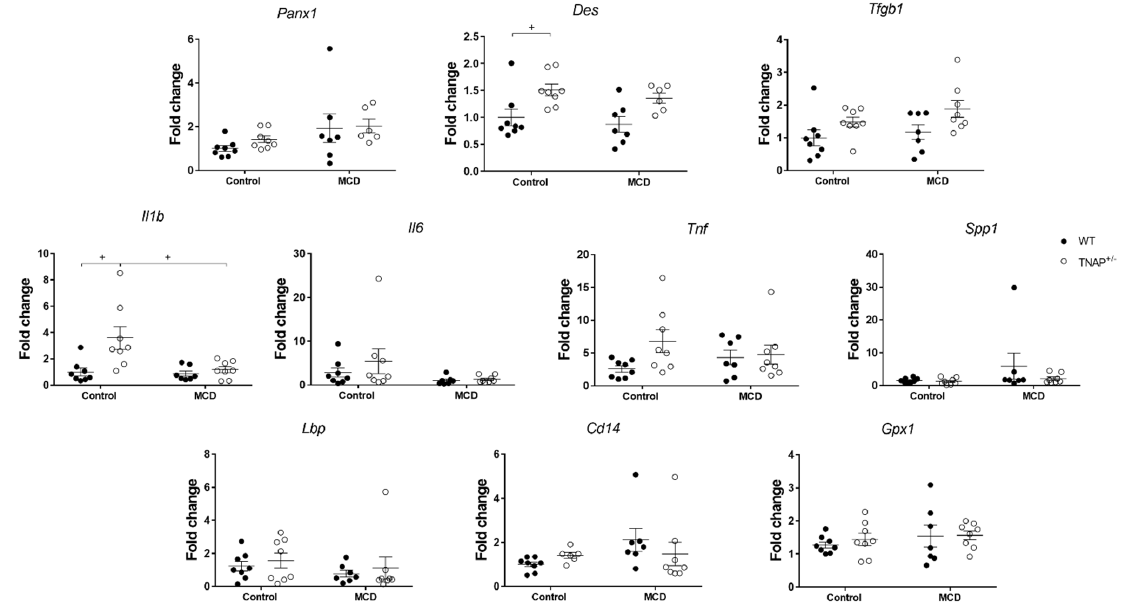
Figure 2. Hepatic expression of fibrosis and inflammatory genes in wild-type (WT) and TNAP heterozygous mice (TNAP +/ − ) a control diet (10% w/w fat, control) or the same diet deficient in choline and methionine (MCD). Fold change of qRT-PCR data are shown. + p < 0.05.